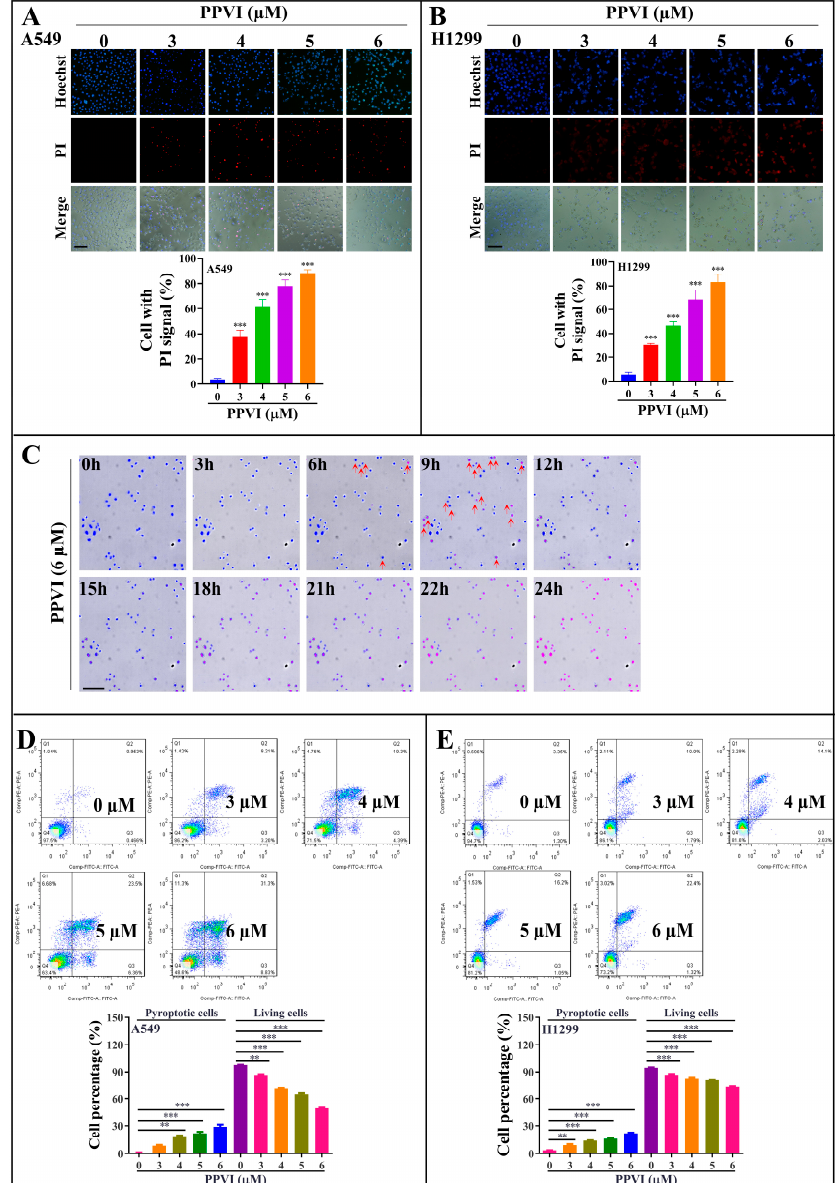
Figure 2. PPVI induces lytic cell death in A549 and H1299 cells. A549 cells ( A ) and H1299 cells ( B ) were treated with PPVI for 24 h. The cells were then stained with 2 µ g / mL PI (red, staining dying cells) plus 2 µ g / mL Hoechst 33342 (blue, staining all cells) for 10 min, and observed by fluorescent microscopy. Bar chart indicates the percentage of cells with PI signal to blue signal; bars, S.D. *** p ≤ 0.001. Magnification: 10 × , Scale bar: 25 µ m. ( C ) The time-lapse phase-contrast and fluorescent images of A549 cells stained with PI and Hoechst 33342 solution were taken at the indicated timepoints after the stimulation of 6 µ M PPVI. The images in the red, blue and white channels were merged at the same field. Red arrow indicated the cells at 6–9 h, beginning with membrane blebbing and producing apoptotic body-like cell protrusions (termed pyroptotic bodies) prior to plasma membrane rupture. The real-time video was included in Video S1. Data shown are representative of at least three independent experiments. Magnification: 10 × , Scale bar: 100 µ m. Pyroptotic cells or living cells of A549 cells ( D ) and H1299 cells ( E ) treated as indicated graded concentrations were measured by flow cytometry using an annexin V-FITC / PI apoptotic detecting kit. Annexin V + / PI + indicated the pyroptotic cells and annexin-V − / PI − represented living cells. Bar chart indicates the percentage of pyroptotic cells and living cells; bars, S.D. ** p ≤ 0.01, *** p ≤